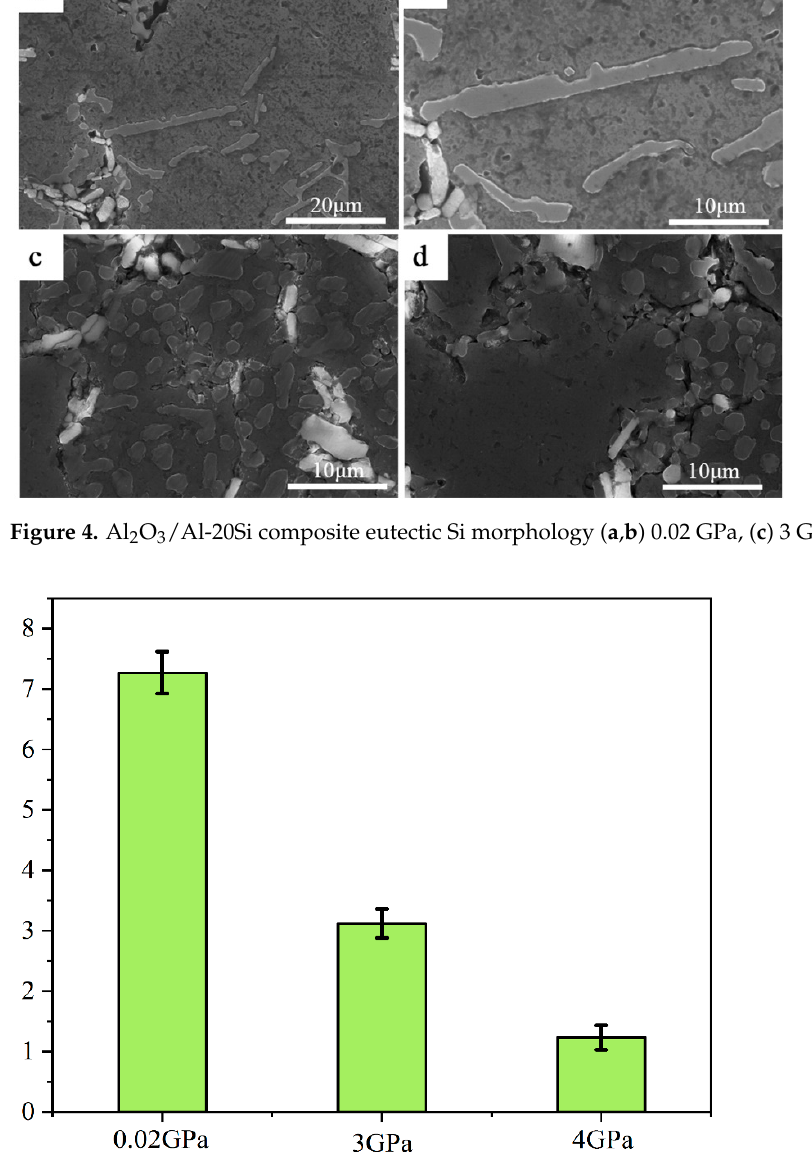
Figure 5. Length-diameter ratio of eutectic Si under different pressures.